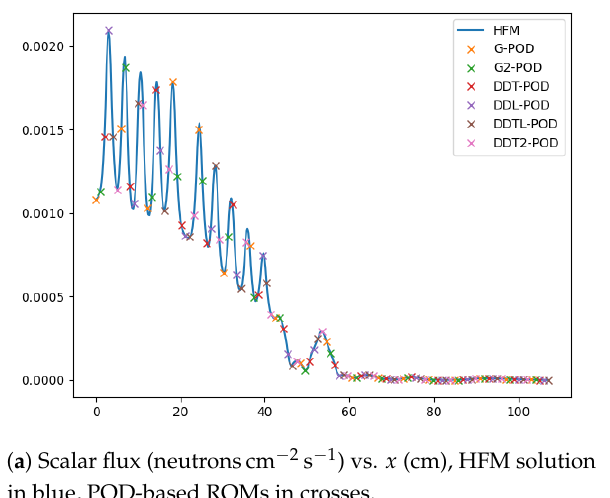
( b ) Absolute pointwise error (neutronscm − 2 s − 1 ) vs. x (cm) Figure 9. Scalar flux for Energy Group 21 for the HFM (blue) and POD methods and the pointwise error between them with parameters R 1 = 2, R 2 = 2, R 3 = 1, R 4 = 1, R 5 =